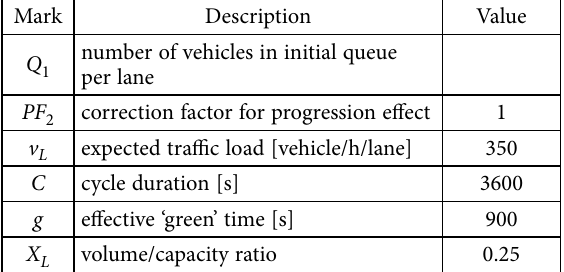
Table 1. Parameters for computing number of vehicles in a queue